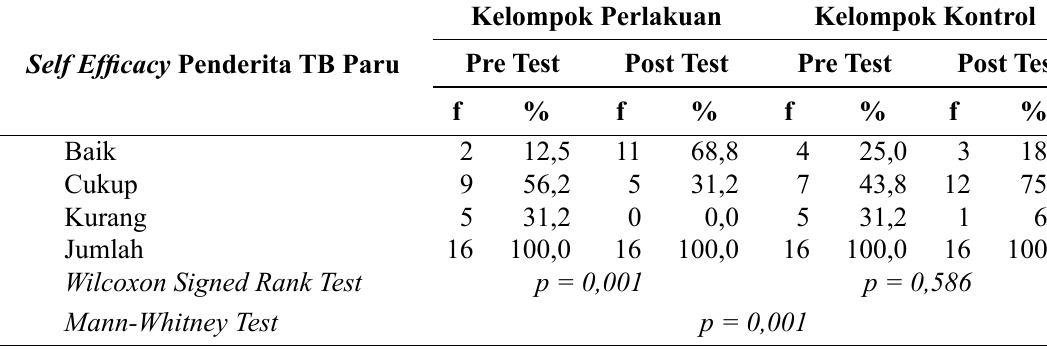
Tabel 4. Distribusi frekuensi self care activity penderita TB Paru